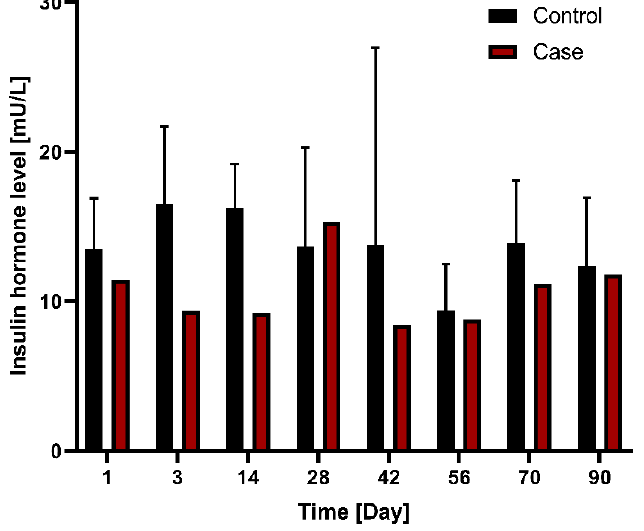
Figure 7. Comparison of changes in insulin hormone levels between the control group ( n = 3) and case group ( n = 1) with G-DFR placement for 90 days. G-DFR, Gastro-duodenal flow restrictor. Collagen formation was assessed as a marker of liver fibrosis via MT staining of the liver. The formation was significantly lower in the case group ( n = 1) than in the control group following G-DFR placement for 90 days (1.40 vs. 2.92% as area of fraction object, p = 0.019) (Figure 8).